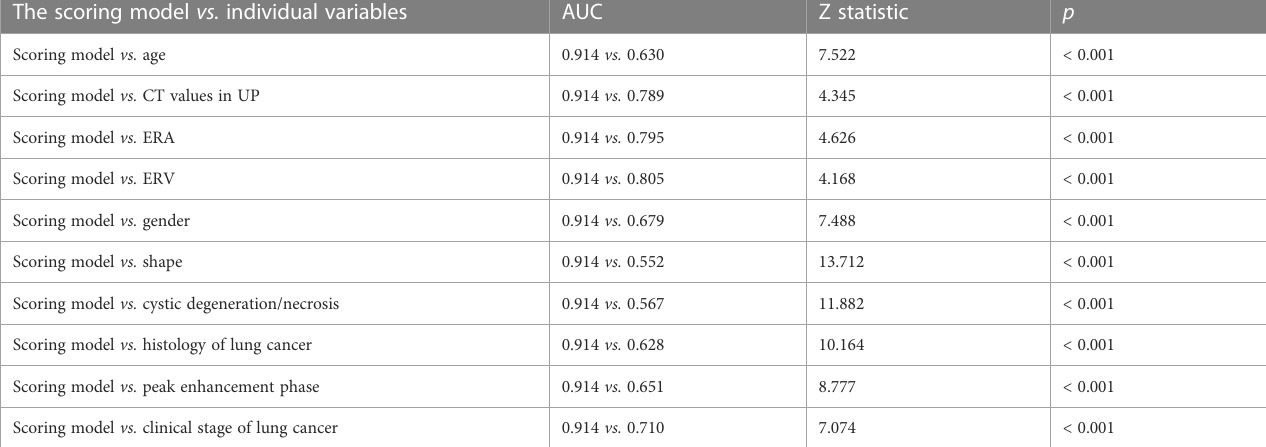
TABLE 4 Comparison of performance of the diagnostic scoring model and individual variables for differentiate metastases from LAPs. The scoring model vs. individual variables Scoring model vs. age Scoring model vs. CT values in UP Scoring model vs. ERA Scoring model vs. ERV Scoring model vs. gender Scoring model vs. shape Scoring model vs. cystic degeneration/necrosis Scoring model vs. histology of lung cancer Scoring model vs. peak enhancement phase Scoring model vs. clinical stage of lung cancer